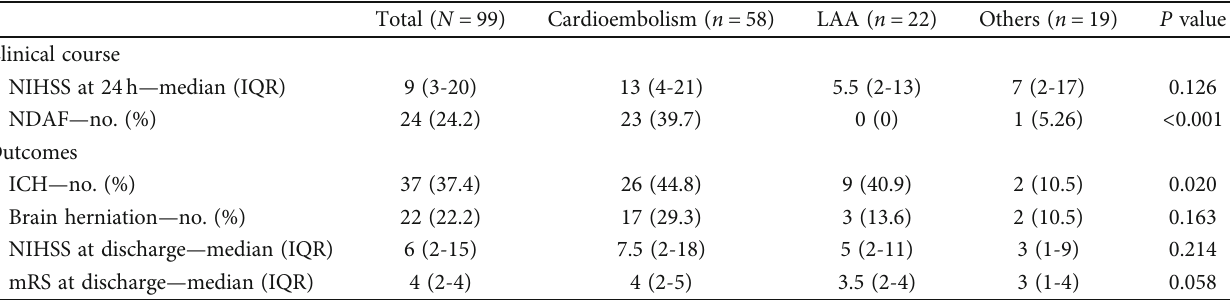
Table 2: Clinical features and outcomes in di ff erent stroke subtypes.